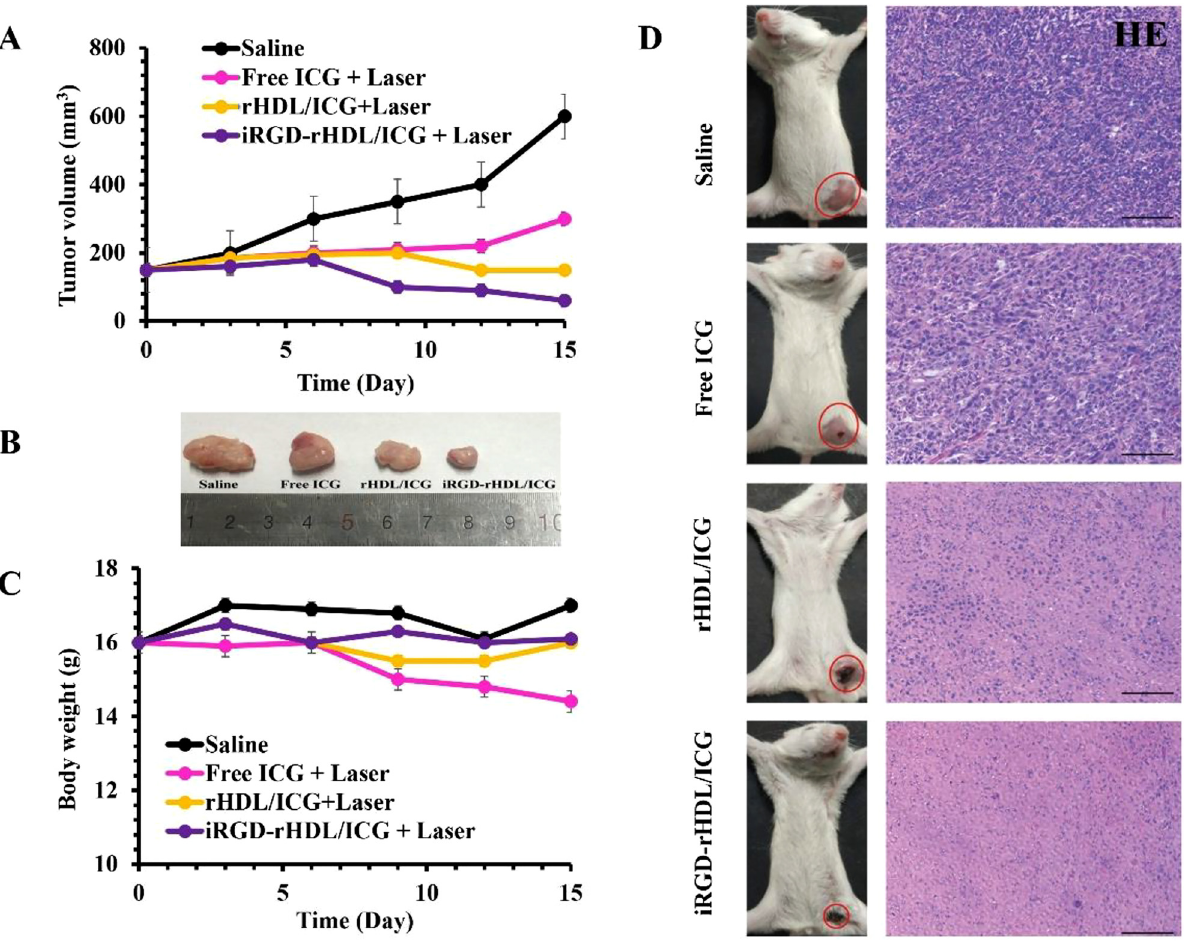
Figure 19: In vivo PDT ef fi cacy in 4T1 tumor-bearing mice. (A) Tumor growth curves after IV-injection of different formulations at an ICG concentration of 1.5 mg kg − 1 ( n = 5). (B) Representative image of tumorsfromthe4T1tumor-bearingmicesacri fi cedafterbeingtreatedwithdifferentformulations with1.5mgkg − 1 ofICG1.(C)Changesinbody weightoverthePDTtreatmentperiod.(D)Hematoxylinandeosin(H&E)imagesofthetumortissuesectionafterPDTtreatmentwith1.5mgkg − 1 ofICG1.Scalebaris100 μ m.Dataarepresentedasmean ± SD, n =3;thelightexcitationisat808nm,1.8Wcm − 2 for5min.AdaptedfromSheng et al. [46]. With permission from Royal Society of